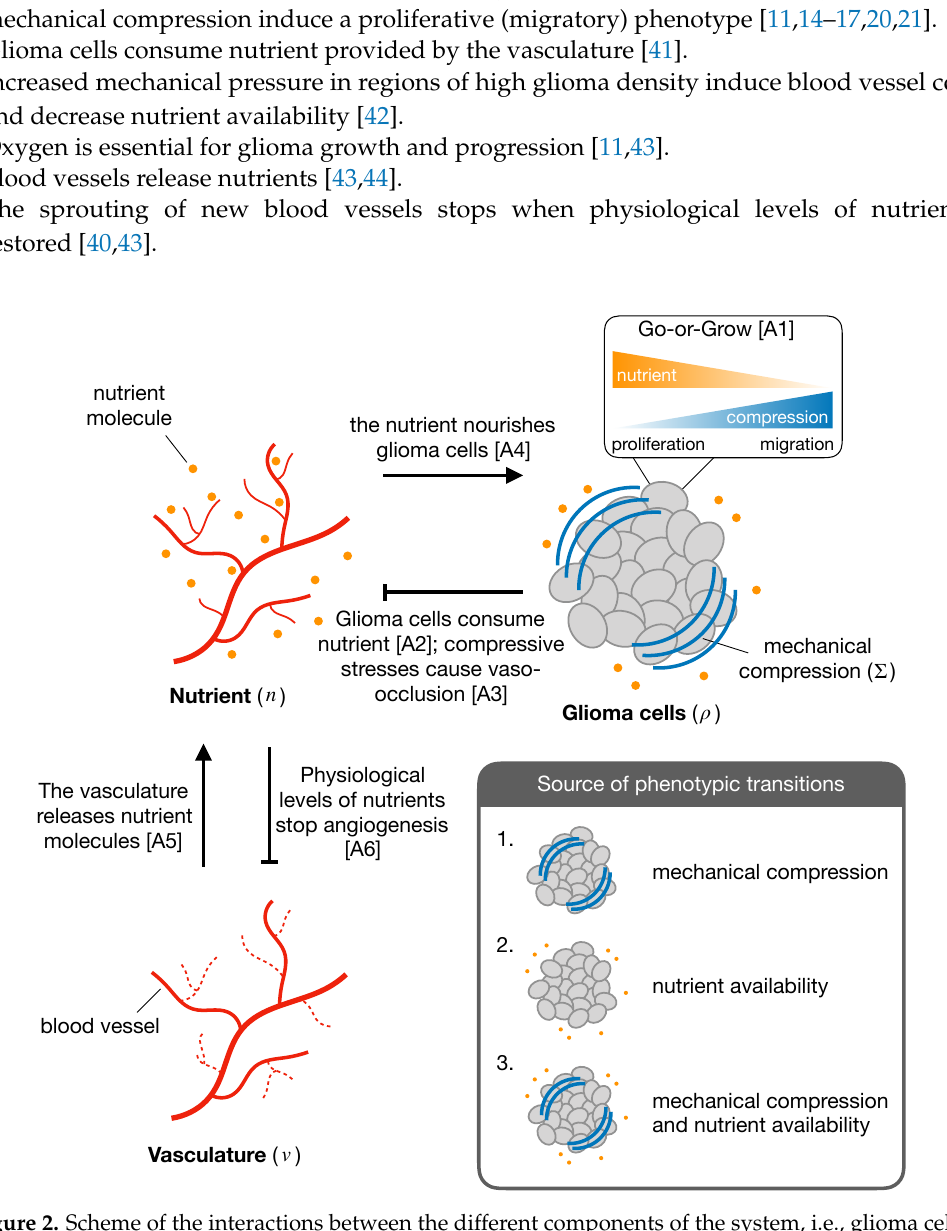
Figure 2. Scheme of the interactions between the different components of the system, i.e., glioma cells, nutrient availability and vasculature. The inset displays the different sources of phenotypic transitions in glioma cells considered in the